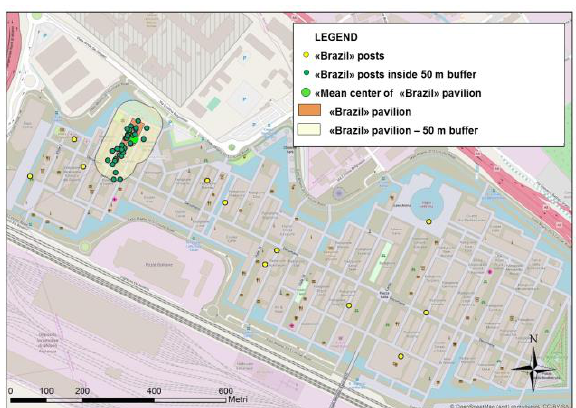
Figure 5. Example of results of the two-step ‘PLACE’-Buffer procedure for the semantic validation of the posts (case: Brazil pavilion); green dots represent the validated